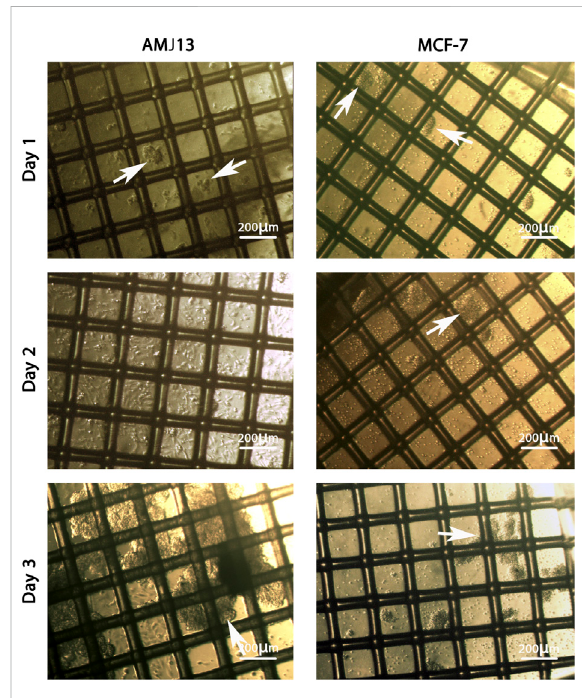
The growth of the spheroids coculture system of AMJ13- hATMSCs and MCF7-hATMSCs on a scaffold dish under an inverted microscope. On the fi rst day, the spheres were minor in size, and the tiny aggregates of spheres (white arrows) were organized as a small network. At 48 h, the spheres contained a small number of cells individually, while another aggregate had many cells aggregated (white arrows). At 72 h, the spheres of the coculture extend in size to connect with the scaffold fi ber and form massive spheroids (white